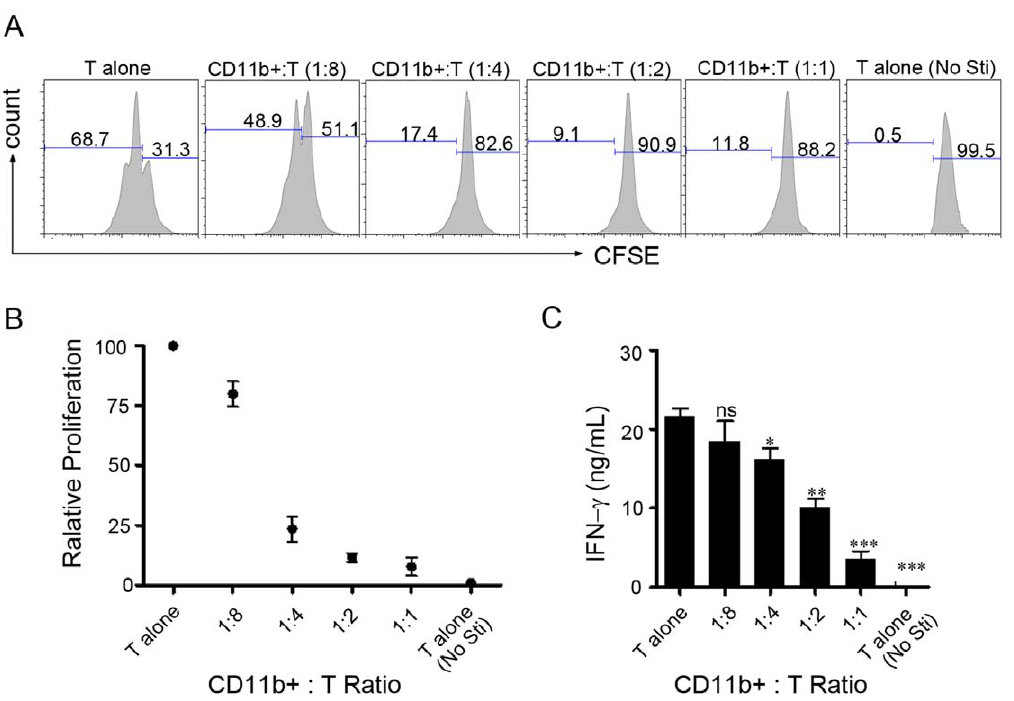
Figure 4. Gr-1 + CD11b + myeloid cells inhibit T cells proliferation and activation in vitro. Purified 3 6 10 5 CFSE labeled T cells were cultured with 6 m g/mL anti-CD3, in the presence of different ratio of purified CD11b + Gr-1 + cells. CD11b + cells purification procedure was described in Materials and Methods . 60 hour later, the cells were harvested and analyzed by FACS. (A) Representative histograms showing the proliferation of T cells with different ratios of purified CD11b + Gr-1 + cells. (B–C) The relative proliferation and IFN- c production were measured by CFSE dilution or ELISA, respectively. Proliferation of T cells without CD11b + cells was set as 100%. The experiment was performed in triplicates. *P , 0.05, **P , 0.01, ***P , 0.001 in comparison with T cells